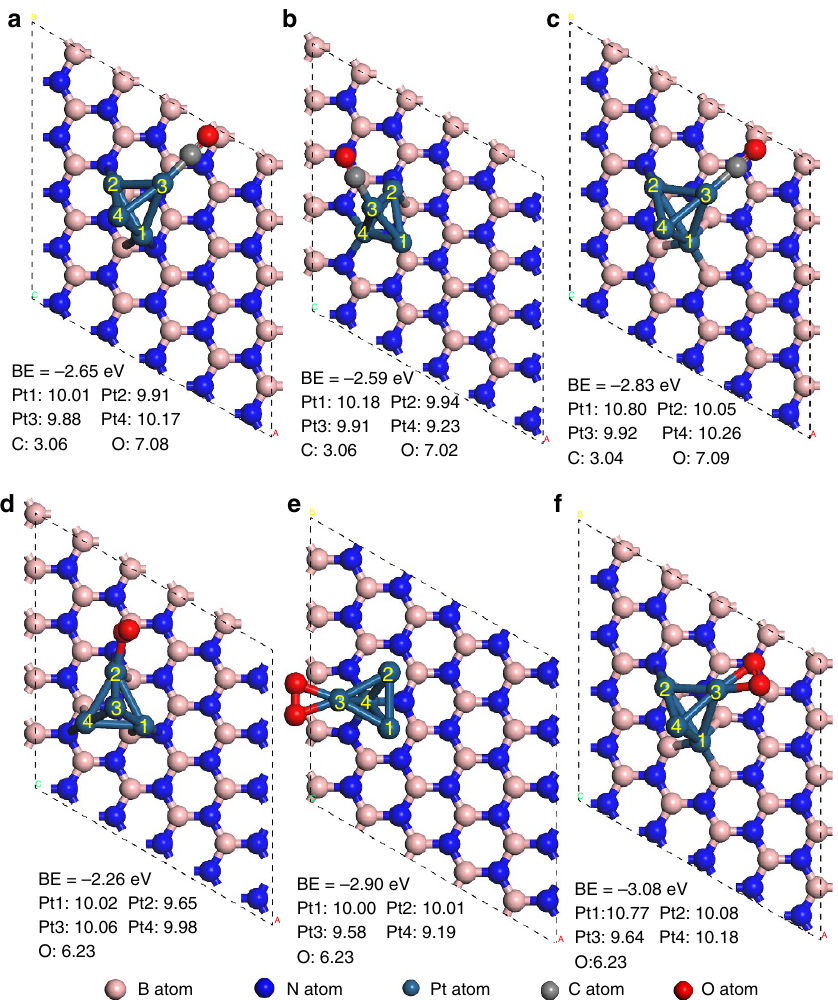
Figure 6 | Most stable configuration of CO and O 2 adsorption and binding energies on Pt 4 cluster. CO adsorption: ( a ) Pt 4 cluster on clean, vacancy-free h -BNNS. ( b ) Pt 4 cluster h -BNNS with Bv. ( c ) Pt 4 cluster on h -BNNS with Nv. O 2 adsorption: ( d ) Pt 4 cluster on clean, vacancy-free h -BNNS. ( e ) Pt 4 cluster h -BNNS with Bv. ( f ) Pt 4 cluster on h -BNNS with Nv.